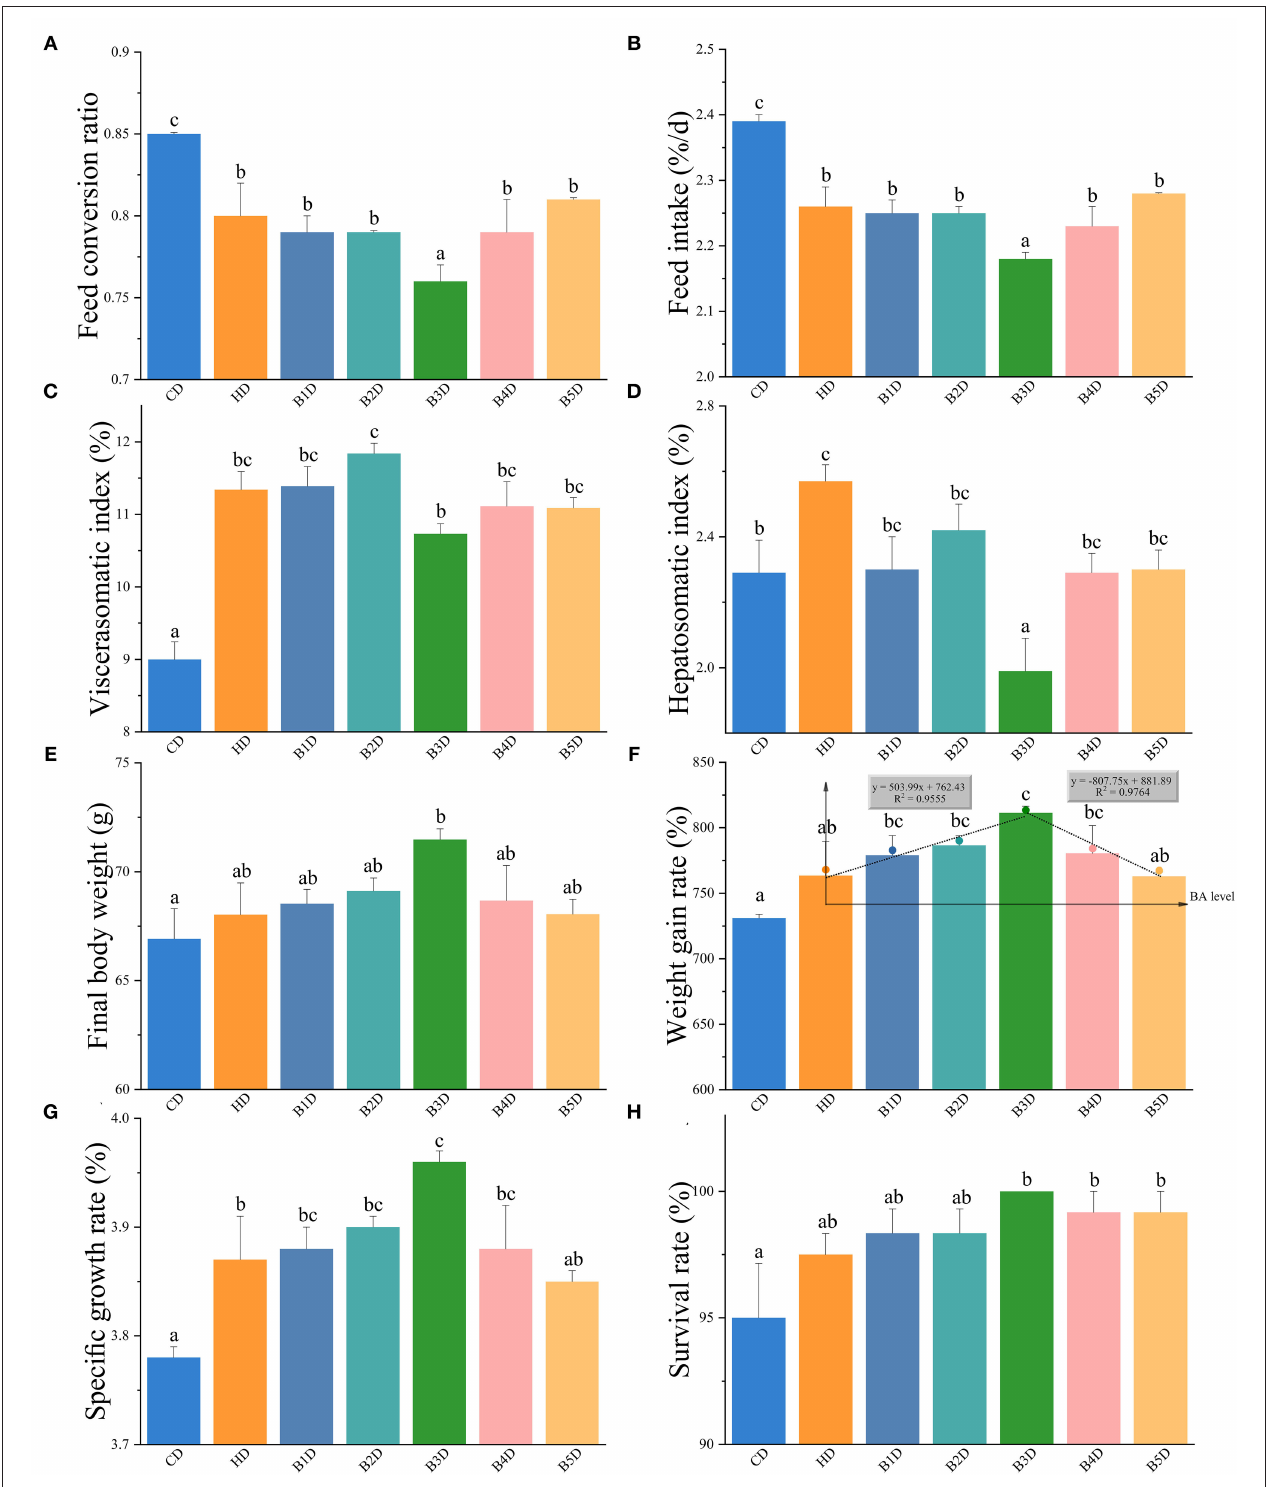
FIGURE 1 | The growth performance of hybrid groupers from HD and BD groups. (A–H) the feed conversion ratio (FCR), feed intake (FI), viscerasomatic index (VSI), hepatosomatic index (HSI), final body weight (BW F ), the weight gain rate (WGR), specific growth rate (SGR), and survival rate (SR) of hybrid grouper fed seven diets for 8 weeks ( n = 4): CD (control), HD (high-lipid), B1D (taurocholic acid sodium additional level at 300mg kg − 1 ), B2D (600), B3D (900), B4D (1,200), and B5D (1,500), respectively. (F) broken line regression equation ( y = 503.99 x + 762.43, R 2 = 0.9555; y = − 807.75 x + 881.89, R 2 = 0.9764) results indicate that the optimal dietary BAs level in a HD diet is 900mg kg − 1 . Values are presented as means with plus error bars (SD, standard deviation), where significant ( p < 0.05) differences between groups are indicated by different letters.